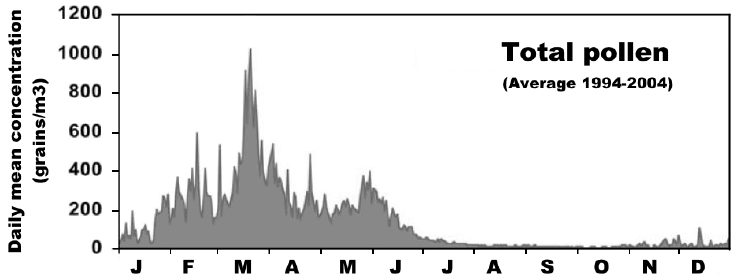
Figure 5. General trend of the local total airborne pollen (adapted from [101]).